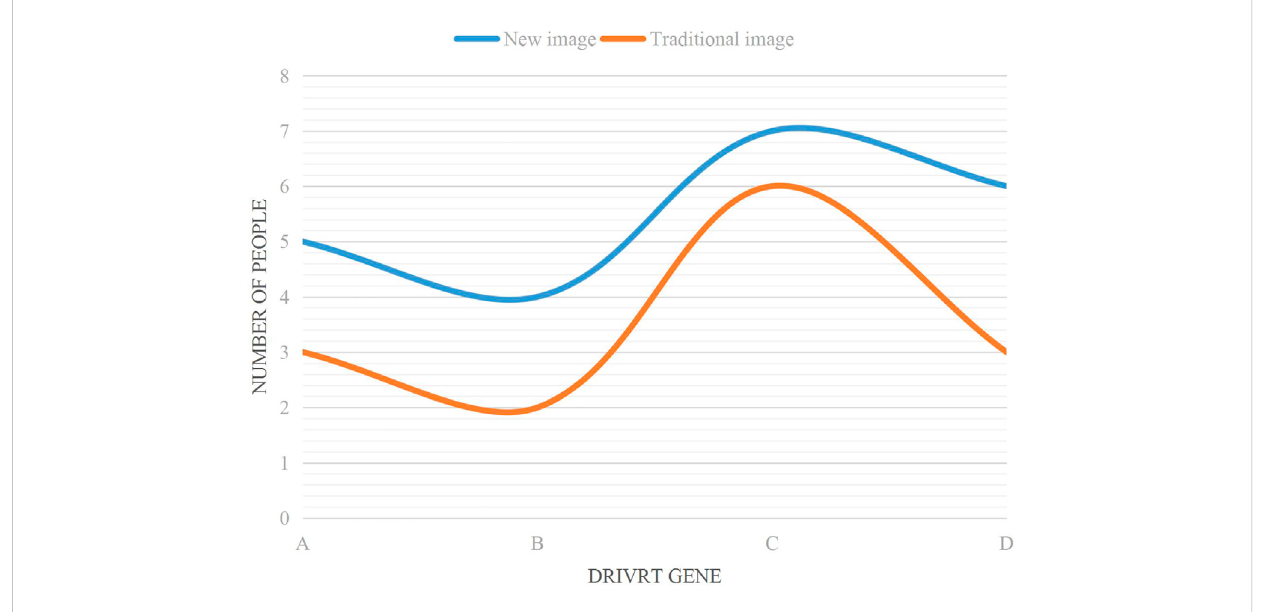
FIGURE 5 Number of gene mutations that can be